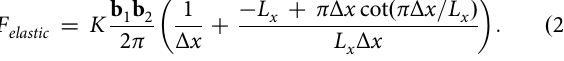
Supplementary Fig. 2 con fi rms that F elastic does not change appreciably with temperature.